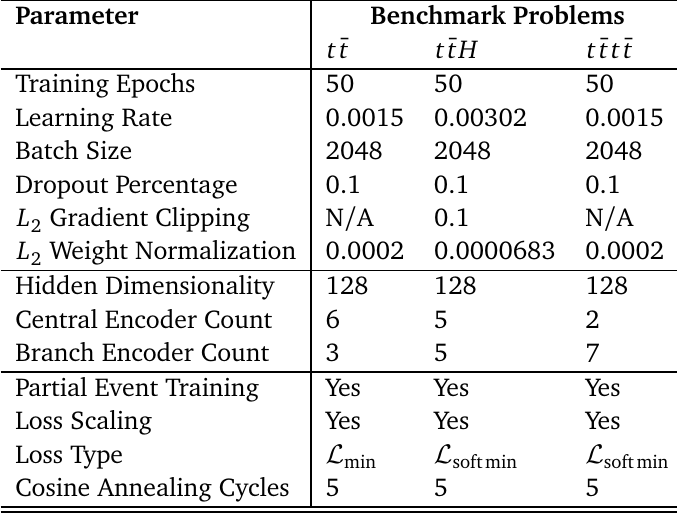
Table 5: A complete table of all hyper-parameters used during S PA -N ET training on all benchmark